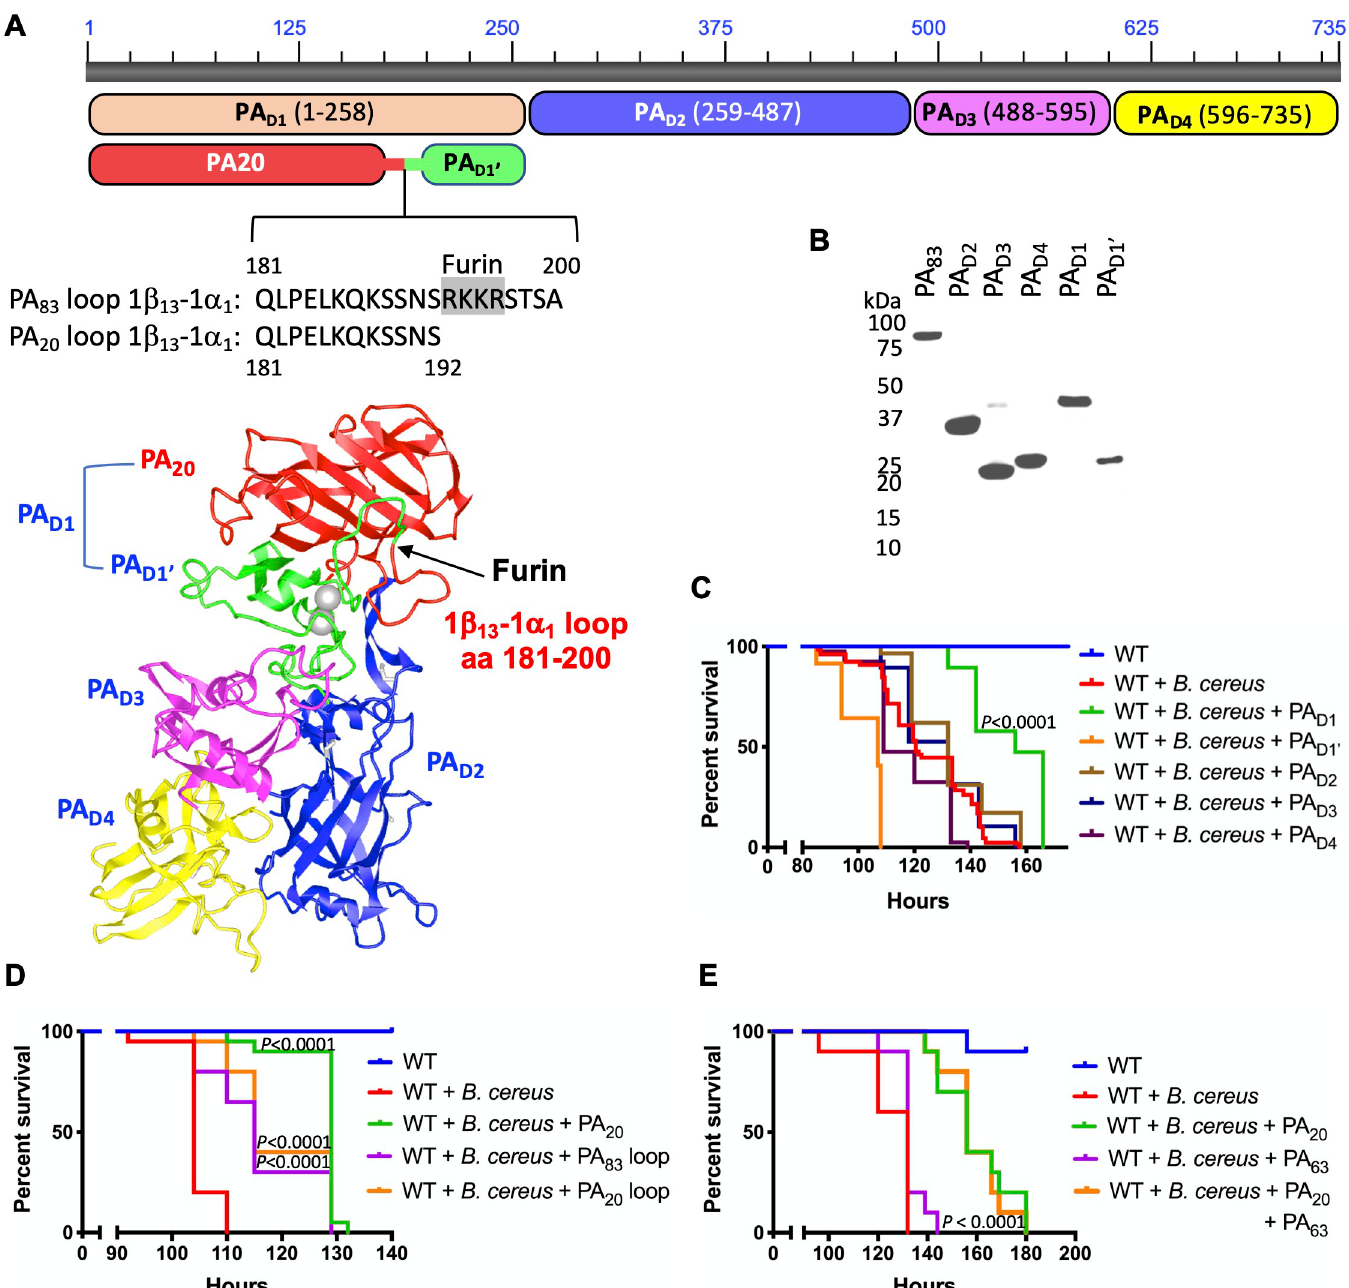
Fig 2. Structure-function analysis of PA 83 . (A) Domain organization in the linear and tertiary structure or PA 83 . The domains and the corresponding amino acids are indicated in the linear structure of PA 83 . The full tertiary structure of monomeric PA 83 is shown using iCn3D (Protein Data Bank ID: 4H2A). The regions in blue, purple, and yellow represent the domains 2, 3, and 4 portions of PA 63 , while the green region represents the portion of domain 1 (aka domain 1’) that remains part of PA 63 after furin cleavage, and the red region represents PA 20 . Furin cleavage occurs in the 1 β 13 − 1 α 1 loop composed of amino acids 181–200. The amino acid sequence of the PA 83 loop 1 β 13 − 1 α 1 connecting PA 20 to domain 1’ is also shown. After furin cleavage (the furin cleavage site is shaded gray), amino acids 181–192 are retained by PA 20 (shown in the second line labeled PA 20 1 β 13 − 1 α 1 loop). (B) Western blot showing the ability of the polyclonal anti-PA 83 antibody to recognize recombinantly expressed and purified PA domains 1, 1’, 2, 3, and 4. (C) The effect of the PA domains 1, 1’, 2, 3, and 4 (PA D1 , PA D1’ , PA D2 , PA D3 , and PA D4 ) on the sensitivity of Drosophila to B . cereus . WT flies of both genders were pooled and challenged with B . cereus with or without individual PA domains. (D) The effect of the 1 β 13 − 1 α 1 loop on the sensitivity of Drosophila to B . cereus . WT flies were challenged with B . cereus with or without PA 20 , PA 83 loop 181–200, or PA 20 loop 181–192. (E) WT flies were challenged with B . cereus in the absence or presence of furin-processed PA 20 , PA 63 , or their combination. P as in Fig 1.